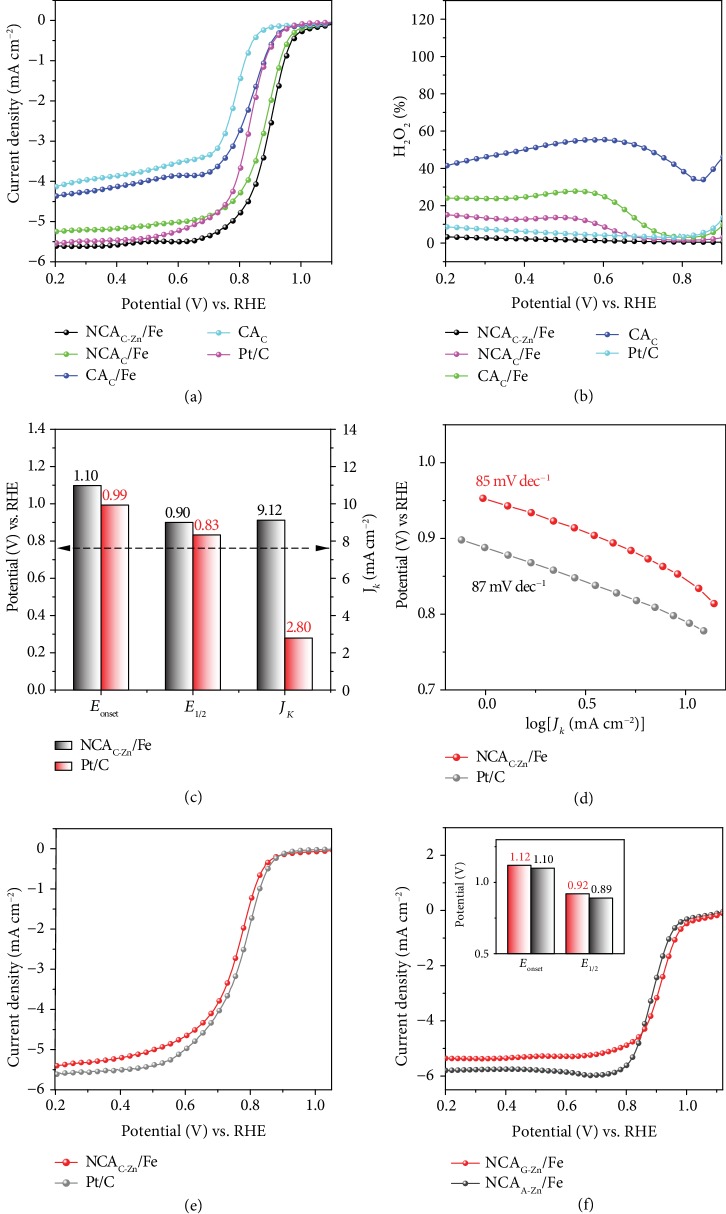
ORR performance. (a) ORR polarization curves of CAC, CAC/Fe, NCAC/Fe, and NCAC-Zn/Fe, as well as the Pt/C at 1600 rpm in 0.1 M KOH at the potential sweep rate of 5 mV s−1. (b) H2O2 yield of CAC, CAC/Fe, NCAC/Fe, NCAC-Zn/Fe, and Pt/C. (c) Eonset, E1/2, and Jk (at +0.85 V) of the NCAC-Zn/Fe carbon aerogels and Pt/C catalyst. (d) Tafel plots of NCAC-Zn/Fe and Pt/C. (e) ORR performance in acidic media. ORR polarization curves of the NCAC-Zn/Fe and the Pt/C at 1600 rpm on RDE in 0.1 M HClO4 at the potential sweep rate of 5 mV s−1. (f) ORR activity of aerogels derived from agar and gelatin hydrogels. ORR polarization curves of NCAA-Zn/Fe and NCAG-Zn/Fe as well as Pt/C at 1600 rpm on RDE in 0.1 M KOH at the potential sweep rate of 5 mV s−1.